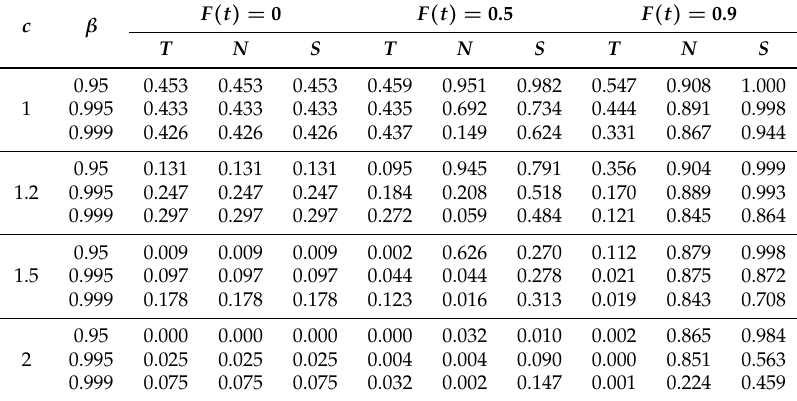
( c ) , H ( c ) , H ( c ) evaluated for various combinations of c , confidence level β , Table 3. Functions H T N S and proportion of unobserved data F ( t ) . The average sample size is n =